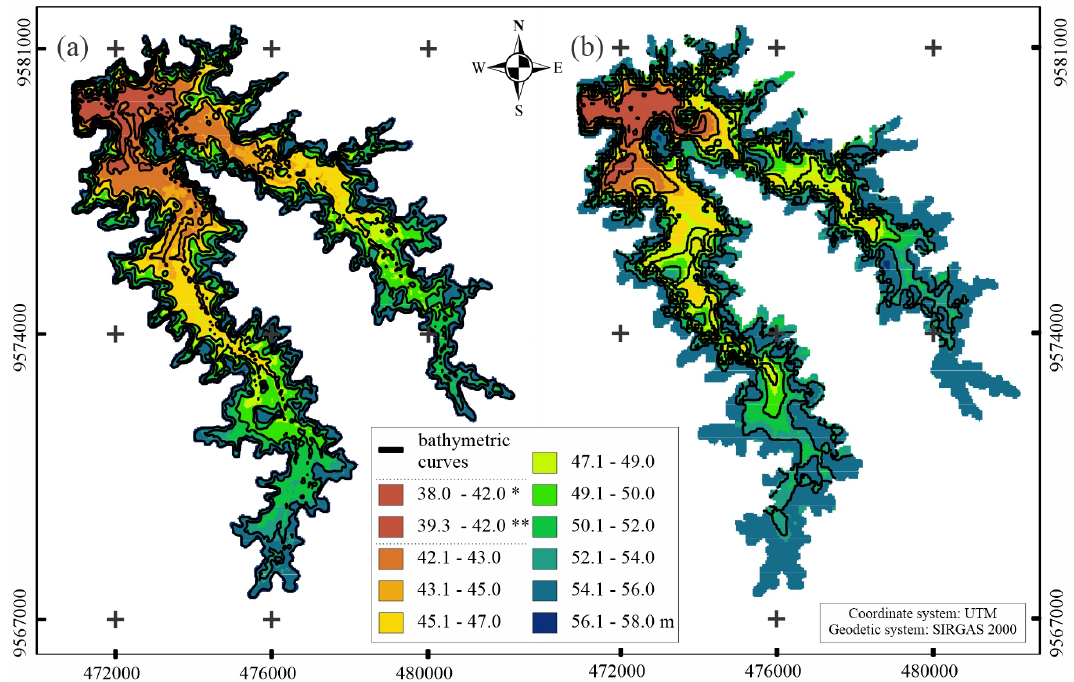
Figure 8. Bathymetric curves and dimensions of the Pentecoste reservoir morphology: ( a ) CBS (Conventional bathymetric survey); and ( b ) BRS (Bathymetric survey using Remote Sensing simplified